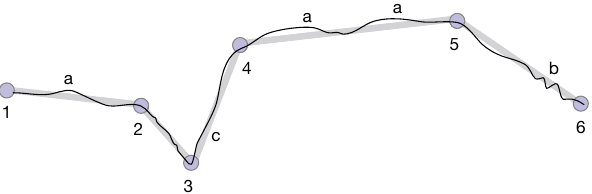
Fig. 2 Picking important points on a motion using simple intuitive principles such as extrema ( a ) or points of high curvature ( b ) can easily fail. In this schematic diagram, the freeform curve represents the motion, and points represent keyframes. Points (1)–(6) nicely summarize this one-dimensional curve, although points (2), (4), (5) are neither points of high curvature nor extrema. Instead of focusing on points individually, our approach considers the error in approximating the intervening motion by pairs of points (visualized as the grey line in this one-dimensional case). For any number of points, we find the optimal set of points in terms of reducing this approximation